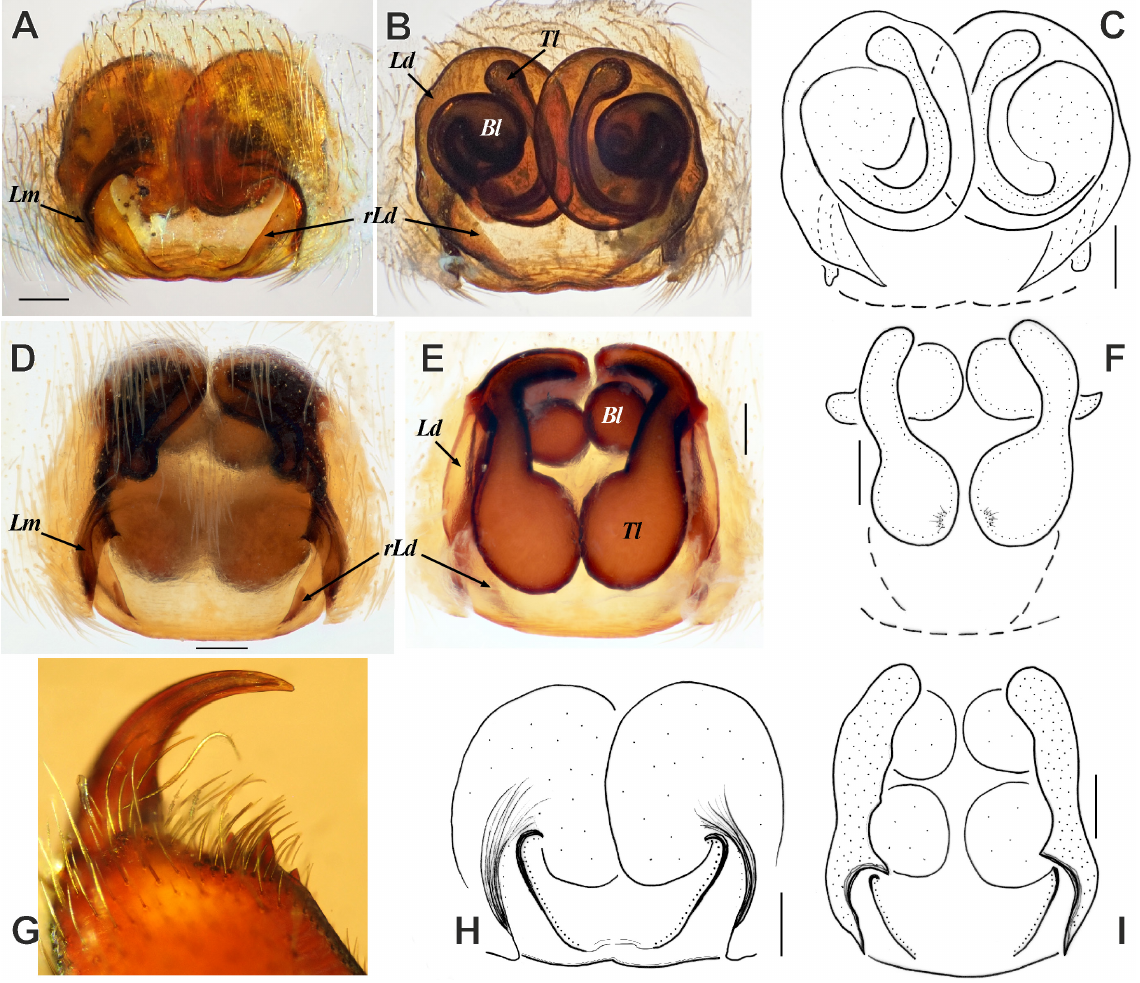
Fig. 19. A–C, G–H . Scotophaeus anahita sp. nov., holotype, ♀ (ZMMU). A, H . Epigyne, ventral view. B–C . Epigyne, dorsal view. G . Chelicera, posterior view. – D–F, I . Scotophaeus elburzensis sp. nov., ♀ (D–E = specimen from Tehran Province, SMF; F, I = holotype, ZMMU). D, I . Epigyne, ventral view. E–F . Epigyne, dorsal view. Abbreviations: Bl = basal lobe; Ld = lateral duct; Lm = lateral margin; rLd = ridge of lateral duct; Tl = terminal lobe. Scale bars: A, C, F, H–I = 0.1 mm; D–E = 0.2